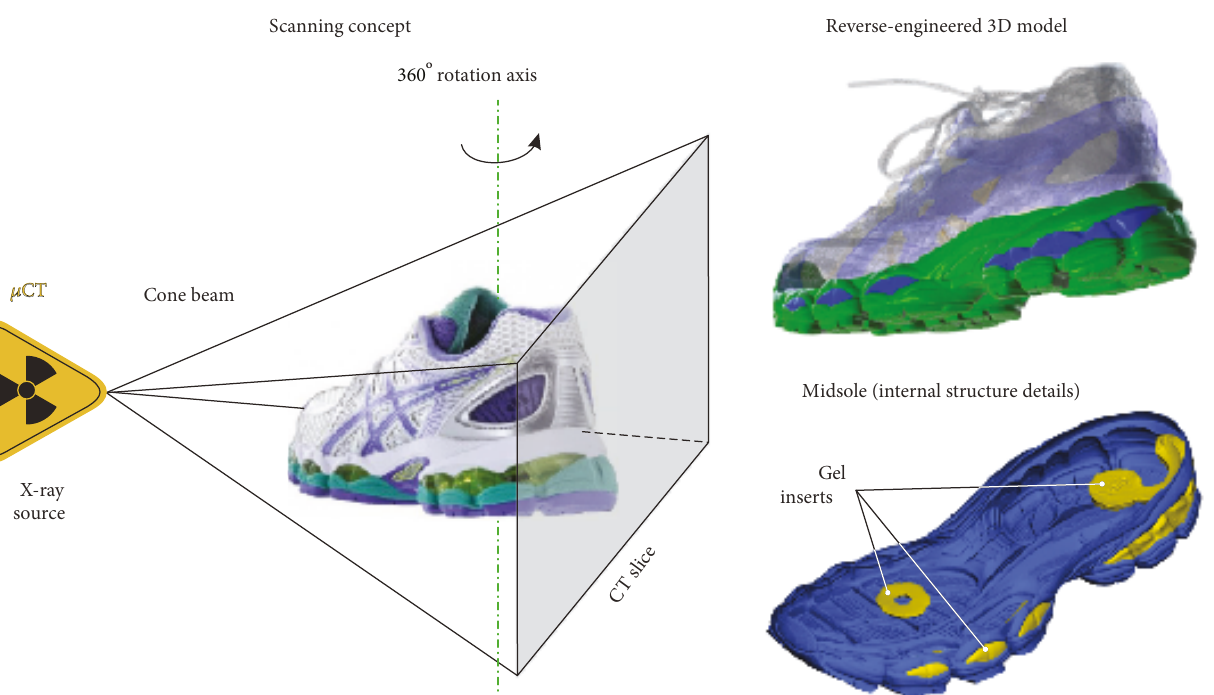
Figure 1: Reverse engineering concept and resulting 3D